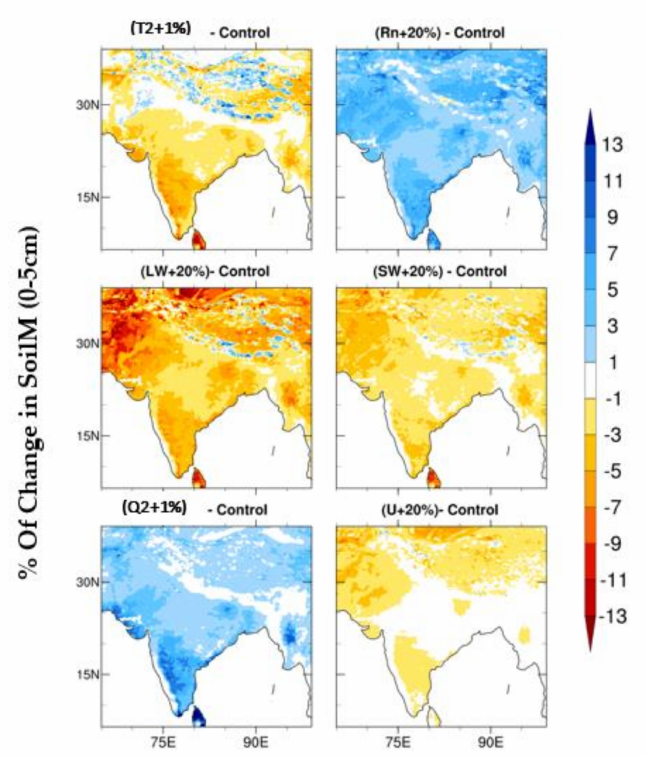
Figure 5. Soil moisture change (%) during JJA in each positive sensitive experiment compared to the control experiment during the year 2013.